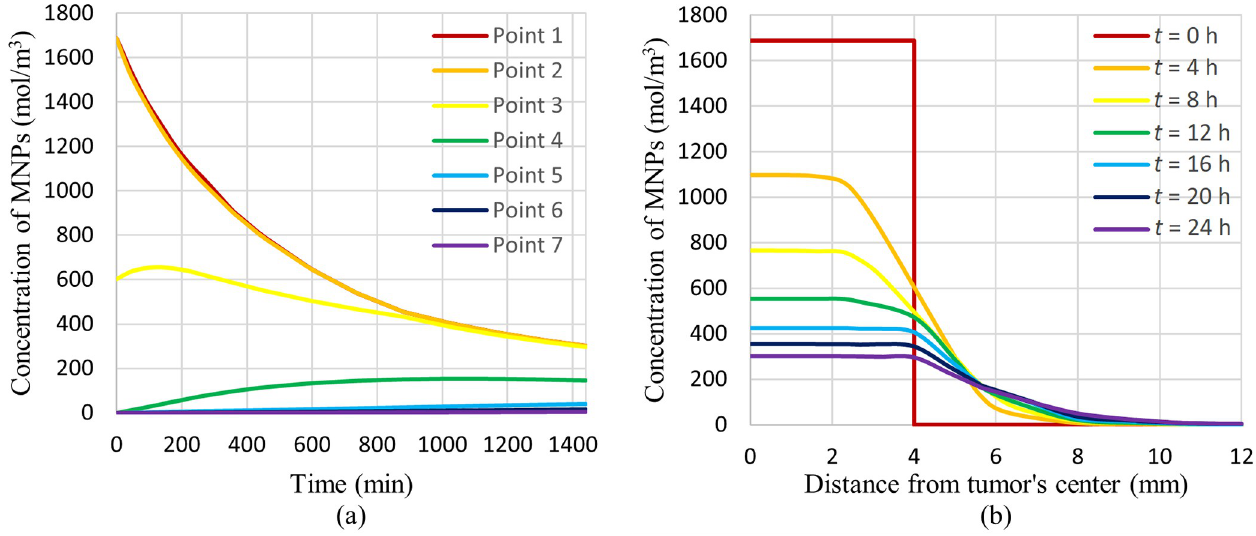
Fig 13. Concentration of MNPs versus, (a) time at different considered points, (b) distance from tumor’s center at different